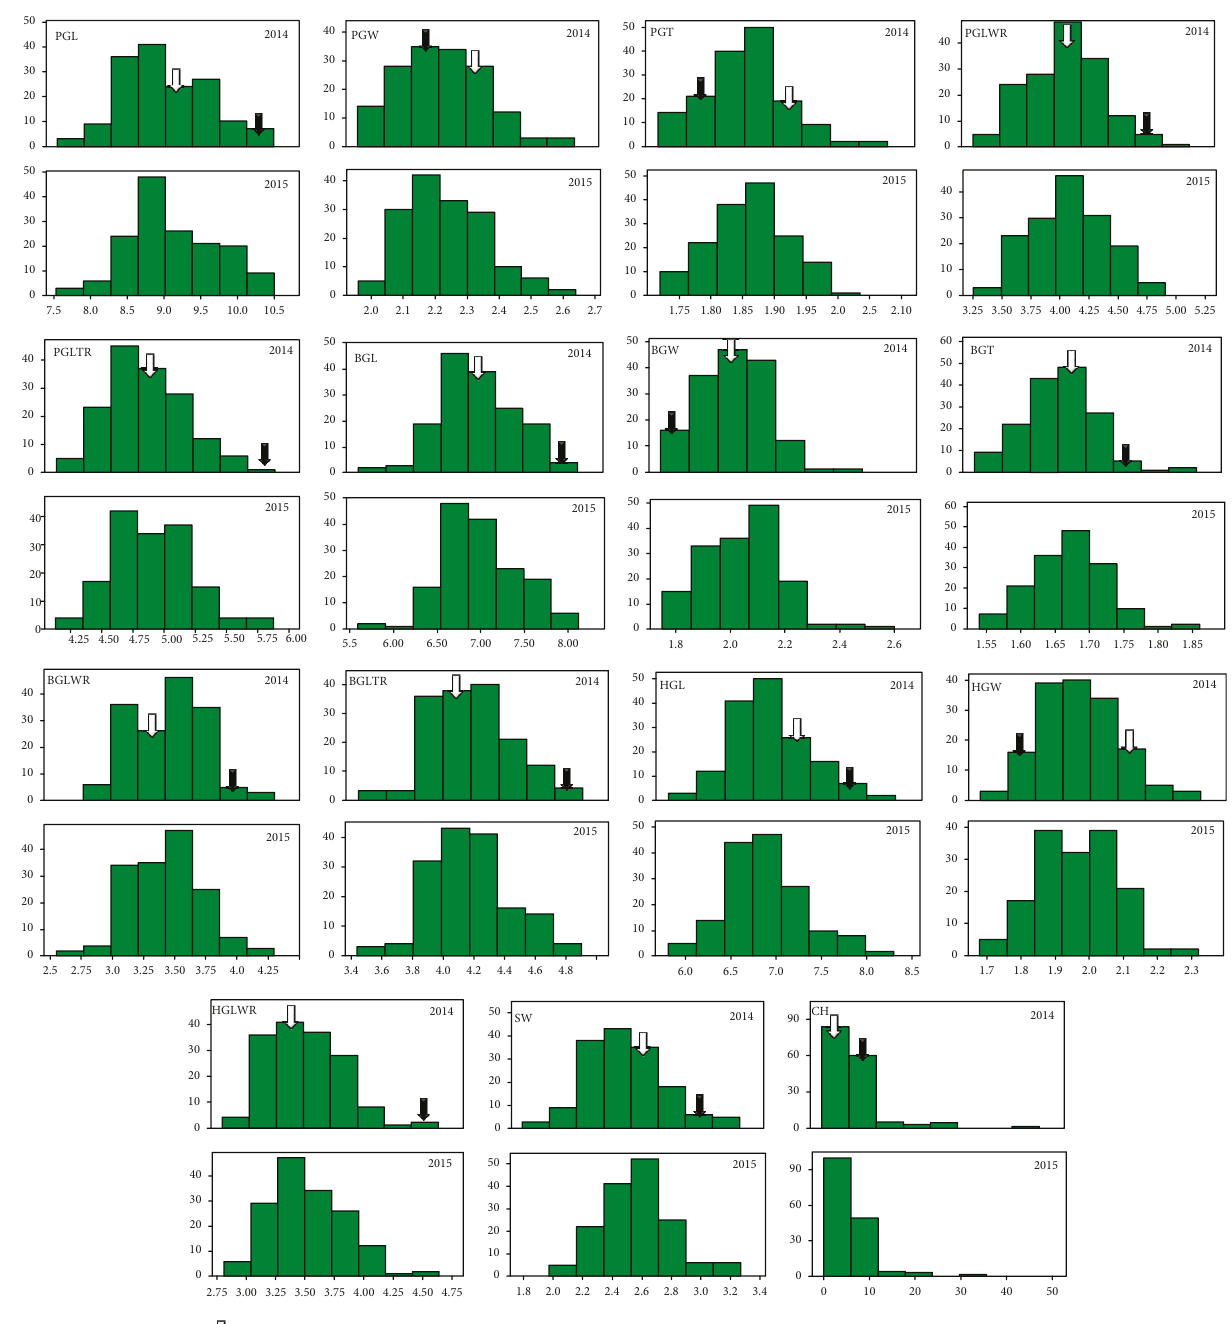
Figure 1: The histogram of frequency distribution of grain appearance quality traits under two seasons in